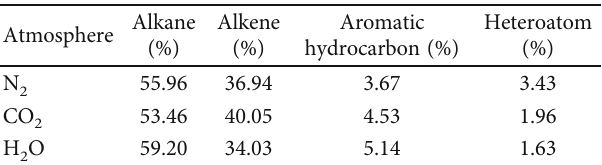
Table 3: Chemical components of pyrolysis oil in di ff erent atmospheres.